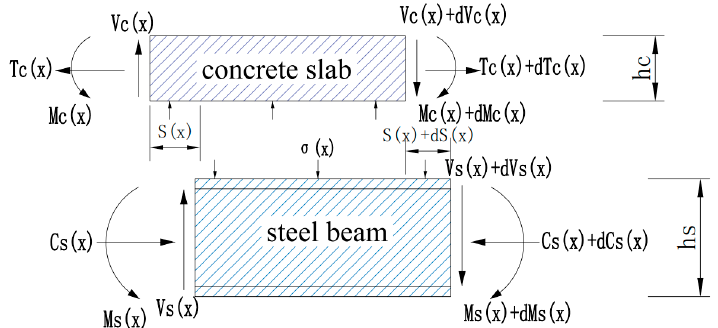
Figure 8. Buckling of the bottom flange of CSB-1.